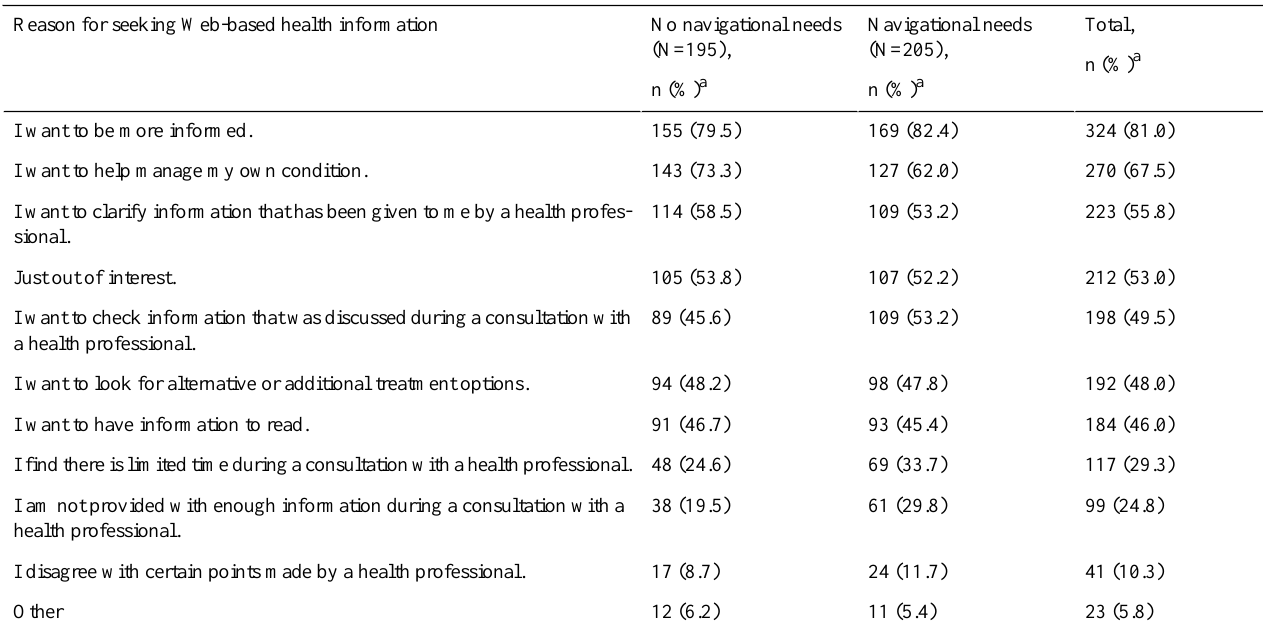
Table 2. Why Web-based health information is sought